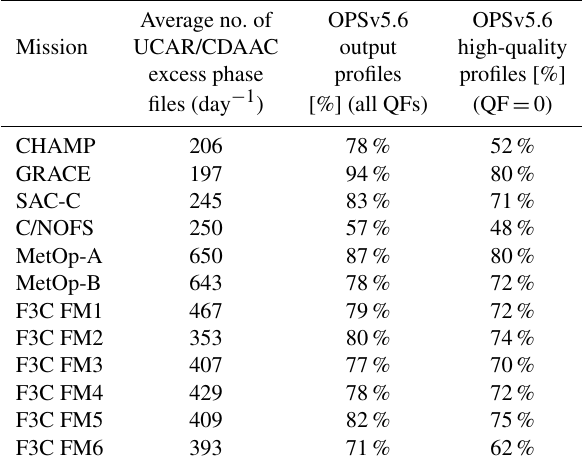
Table 3. Overview of daily average number of available UCAR/CDAAC excess phase files (one file per RO event) and the corresponding percentages of retrieved OPSv5.6 output profiles and high-quality profiles. Average no. of OPSv5.6